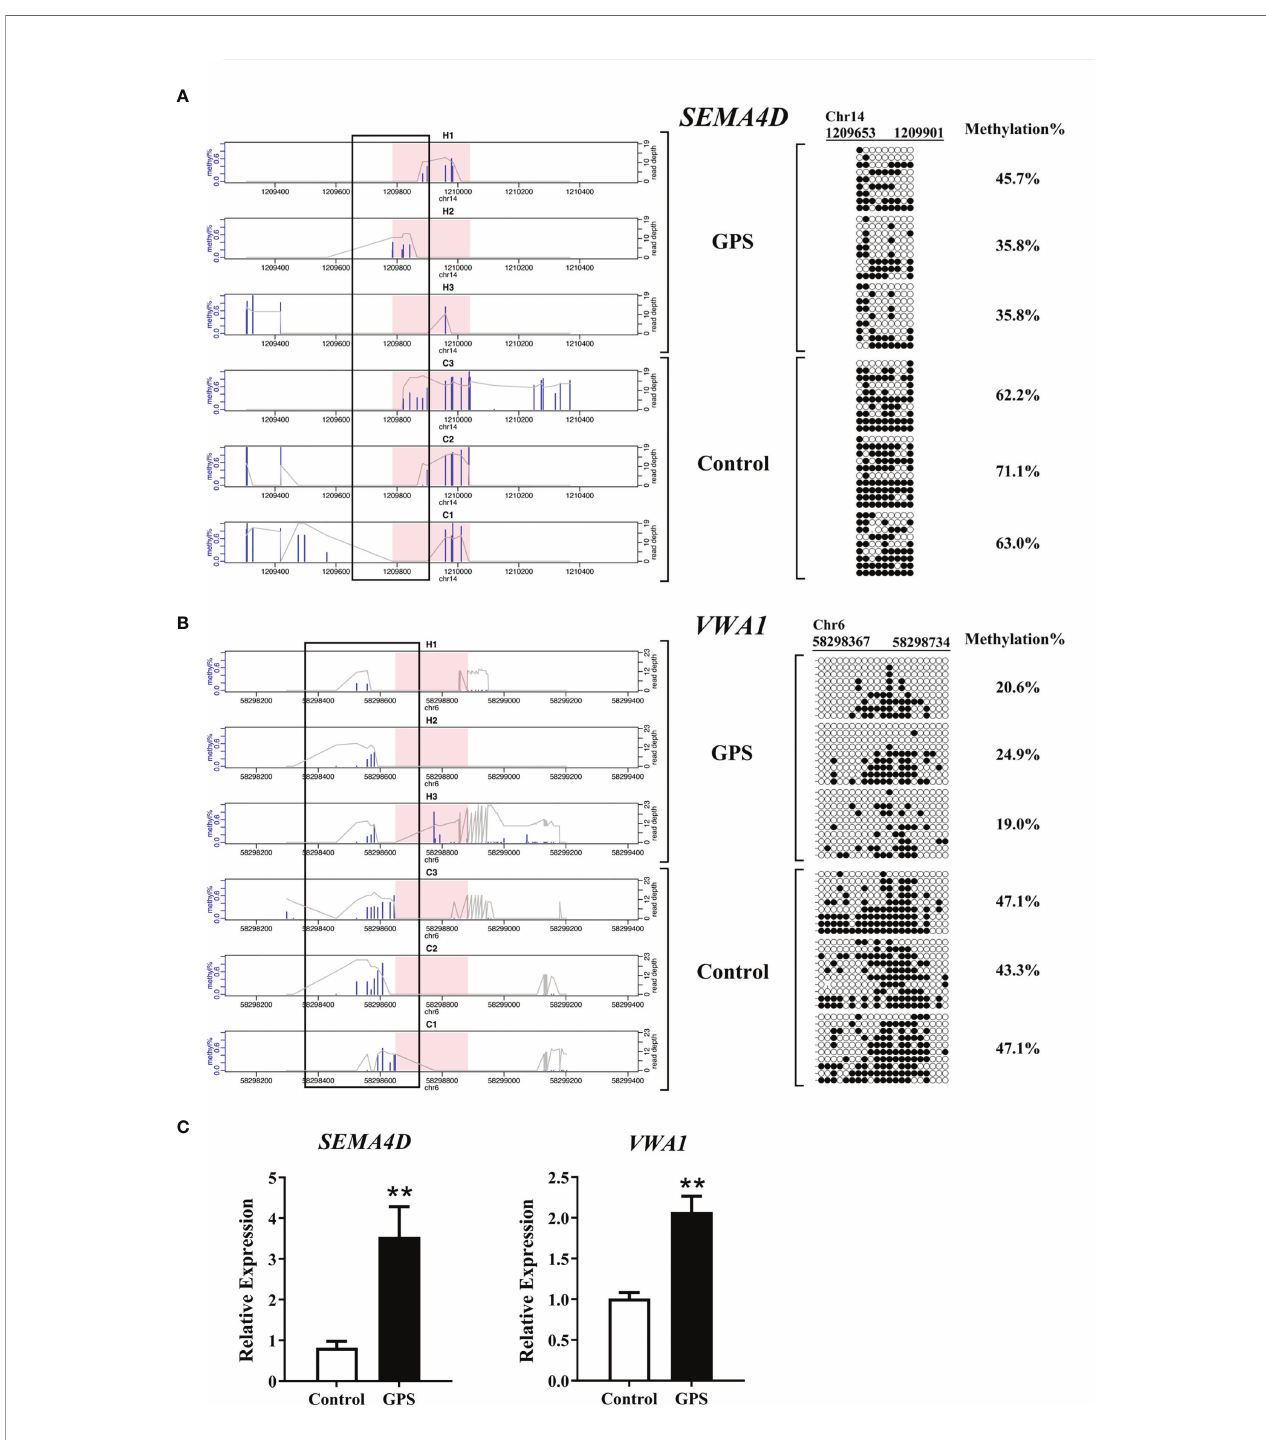
FIGURE 6 | Bisul fi te sequencing and qRT-PCR validation of SEMA4D and VWA1 in G. parasuis -infected vs. control porcine brain. (A) Bisul fi te sequencing validation of SEMA4D. On the left, bisul fi te sequencing depth shows the SEMA4D DMR and adjacent fl aking regions in three G. parasuis -infected and three negative control samples. On the right, targeted bisul fi te sequencing validation of a region overlapping the SEMA4D DMR as indicated by the rectangle over the sequencing tracks. Each row represents a single clone. Dark circles represent methylated and open circles represent unmethylated cytosines. (B) Bisul fi te sequencing validation of VWA1. Similarly, bisul fi te sequencing depth for VWA1 DMR and adjacent fl aking regions is shown on the left, and bisul fi te sequencing validation is shown on the right. (C) qRT-PCR validation of SEMA4D and VWA1 . The vertical axis indicates the relative expression levels of SEMA4D or VWA1 in reference to b -actin, and the horizontal axis indicates the G. parasuis -infected vs. negative control samples. ** P <